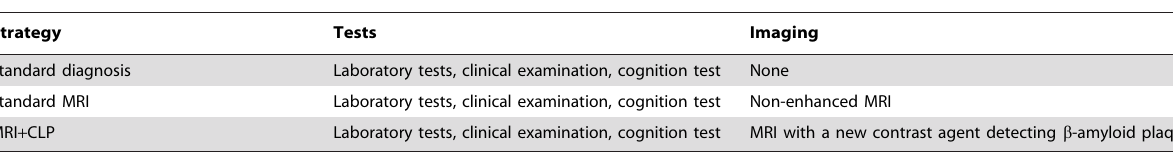
Table 1. Compared strategies.